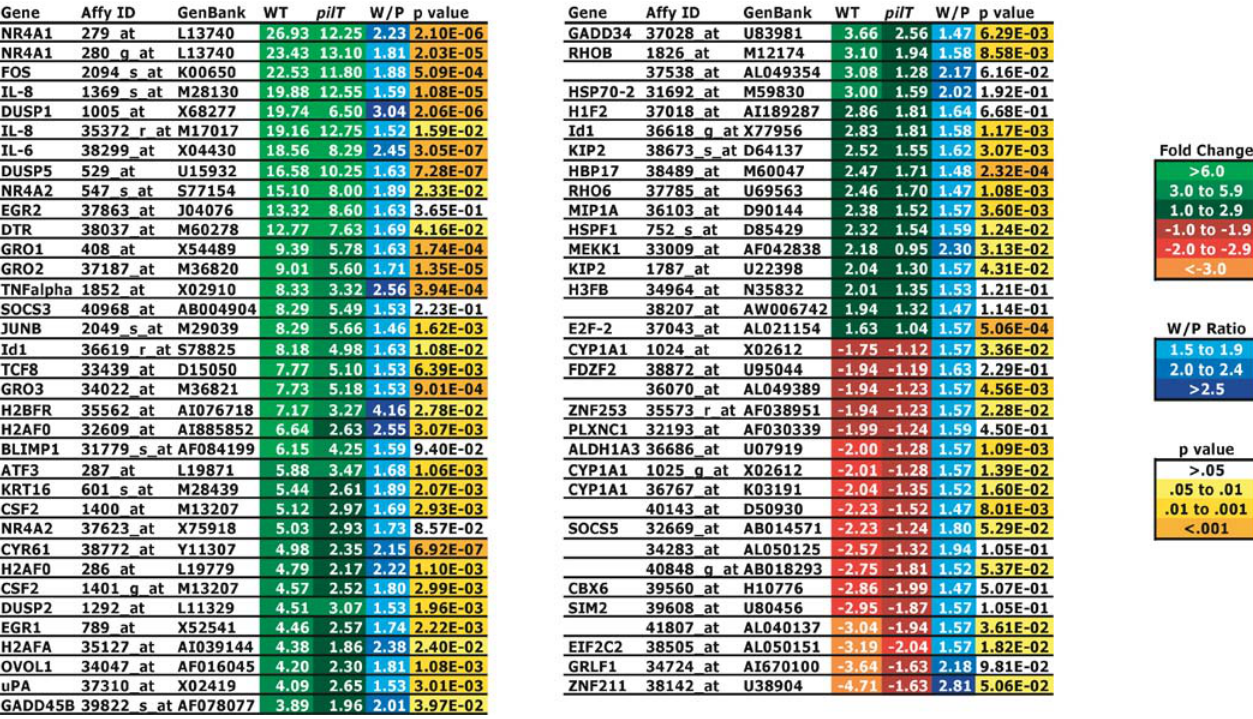
Figure 1. Infection-Regulated, Retraction-Enhanced Epithelial Cell Genes Wt and pilT values represent the mean fold-change in the transcript level of each gene in infected cells compared to uninfected cells ( n = 2). W/P values represent the degree of enhancement of gene expression resulting from pilus retraction and are the result of dividing the wt fold-change value by the pilT fold-change value from two independent experiments. The p -value for each gene represents the statistical significance of the difference in its expression level (as determined by Cyber-T analysis) between wt and pilT . The color code assigned to each gene represents its degree of response to infection as expressed by its fold-change value, W/P, and p -value. DOI: 10.1371/journal.pbio.0030100.g001 PLoS Biology |